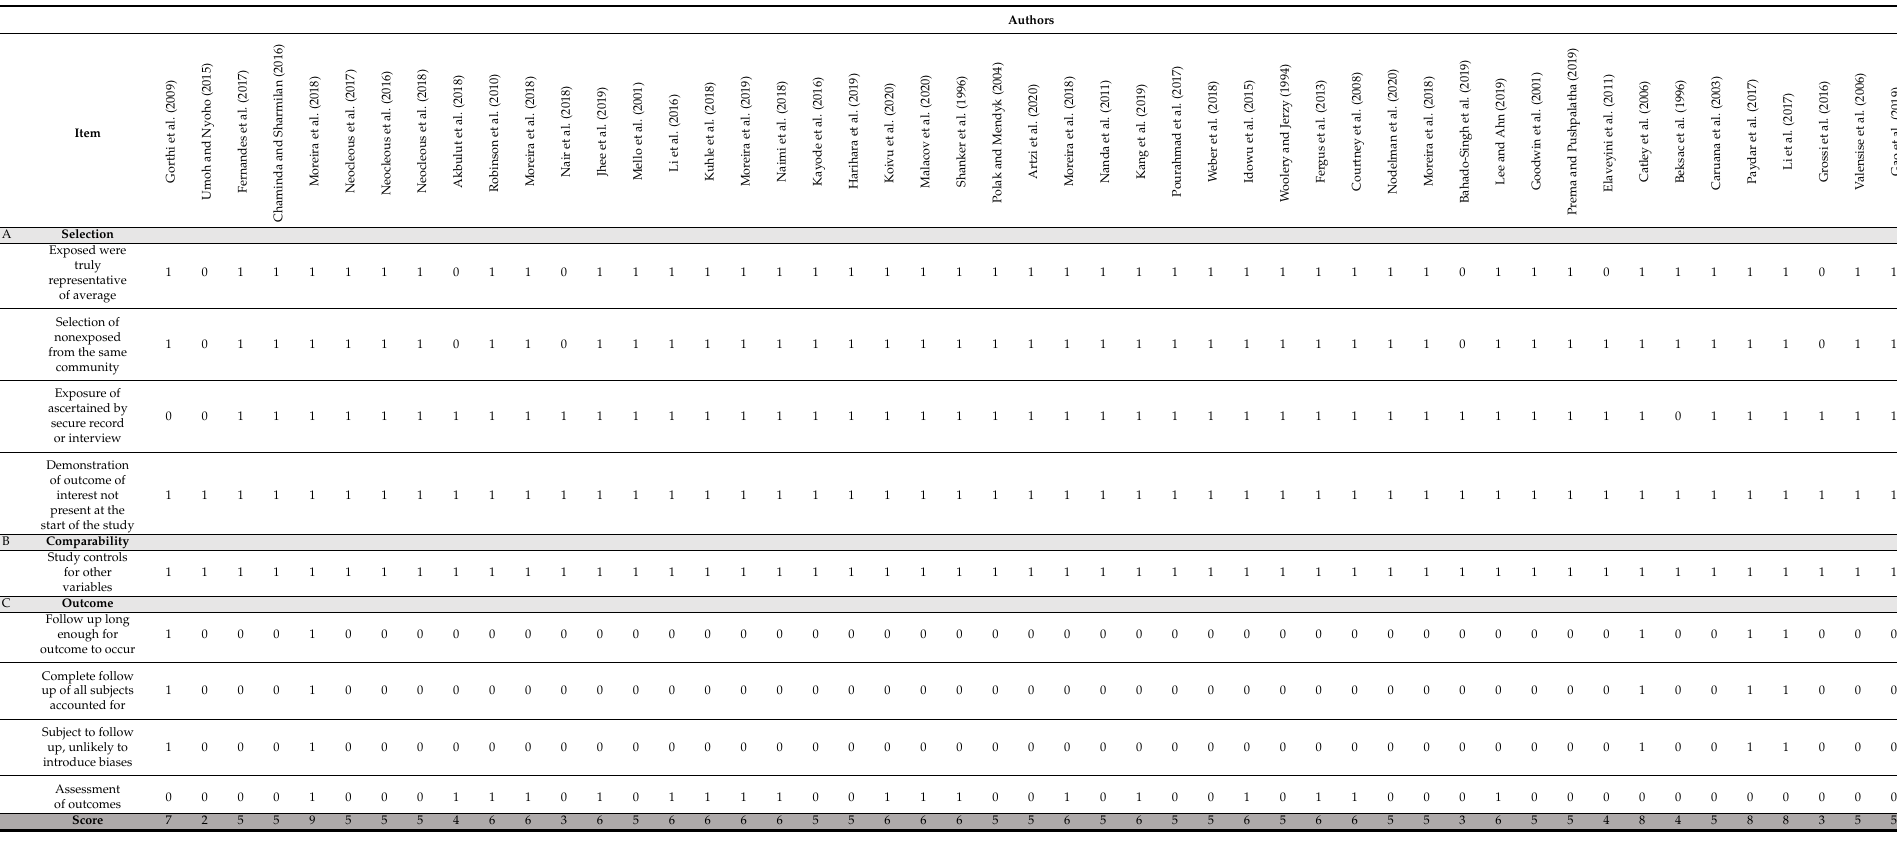
Table 1. The Newcastle–Ottawa scale for quality assessment of included